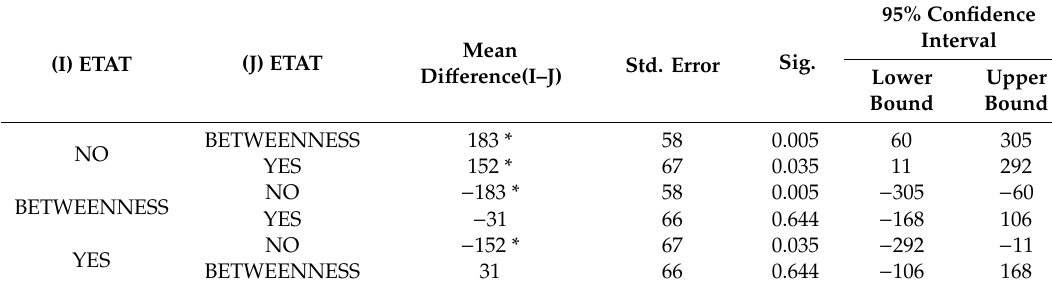
Table 9. Post Hoc Tests: Multiple Comparisons